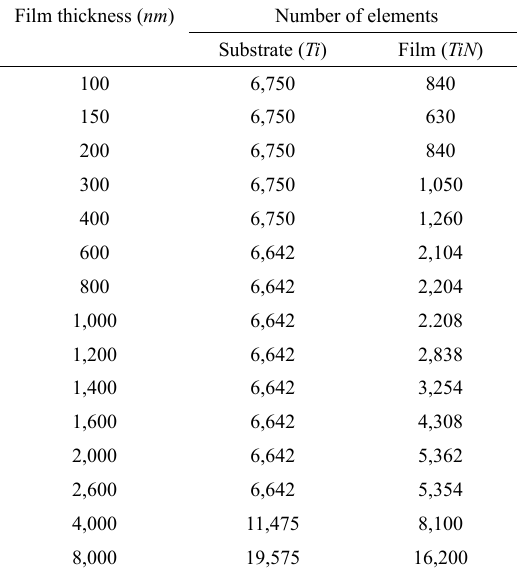
Table 1. Different meshes used during the simulation of instrumented Vickers hardness for the TiN/Ti system. Film thickness ( nm )